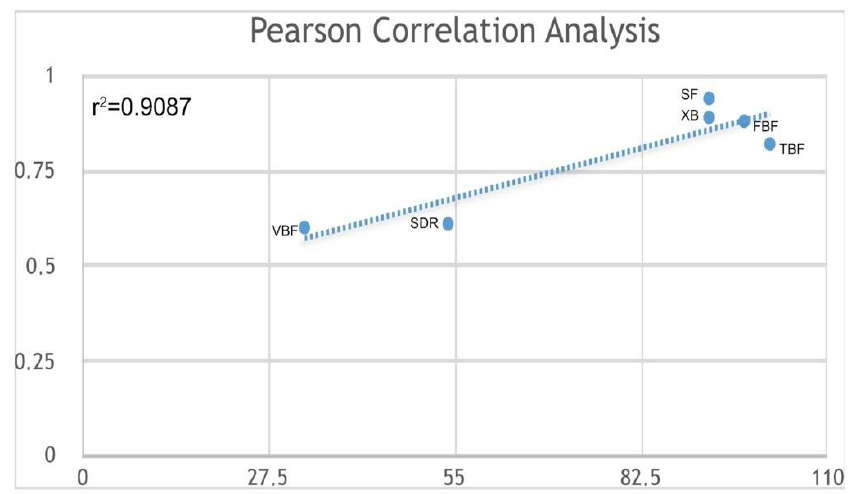
Figure 5. Pearson correlation of max. MH versus SS (MPa) for bulk-fill composites (Venus Bulk Fill (VB); SDR; Xtra-Base (XB); SonicFill (SF); Filtek Bulk Fill (FBF); Tetric Bulk Fill